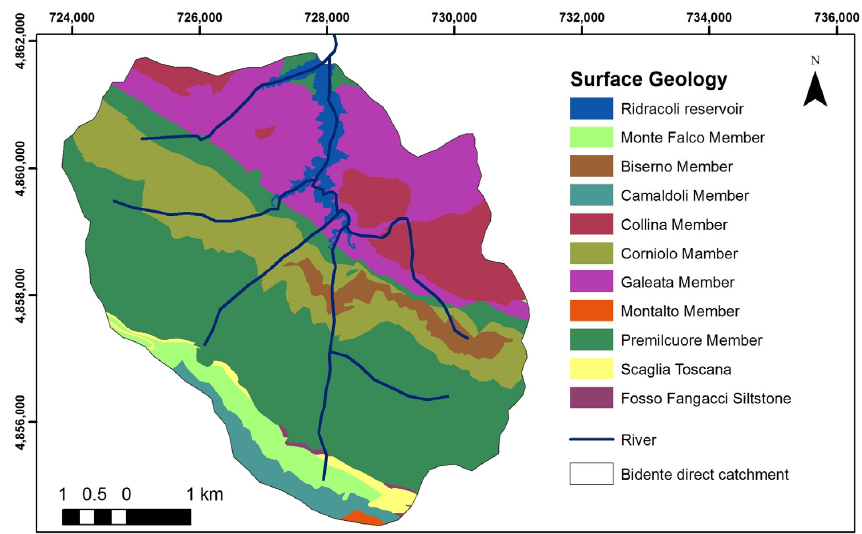
Figure 2. Surface geology of the Ridracoli reservoir catchment. (Map coordinate system: WGS84–UTM zone 32 N). Table 1. Distribution (%) of members included in the Ridracoli reservoir catchement. Listed are also the age, sandstone/pelite ratio (A/P), and the formation. Refer to Figure 2 and to the surface geology of the Emilia-